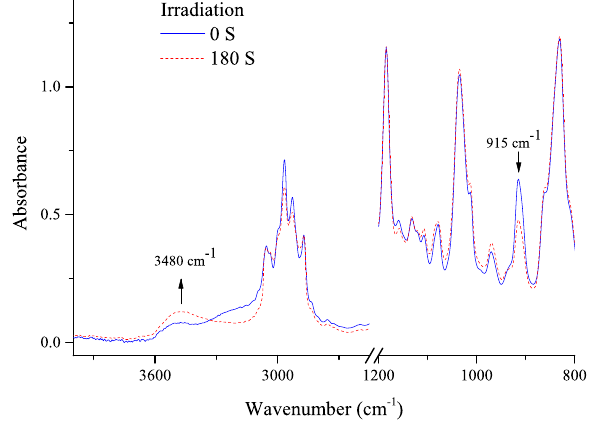
Figure 4. Transmission FT-IR spectra of BAGDE (in the presence of TX) under UV irradiation. Sample preparation conditions: sandwiching the mixture between two KBr salt plates and UV irradiation (1.0 W cm − 2 ).